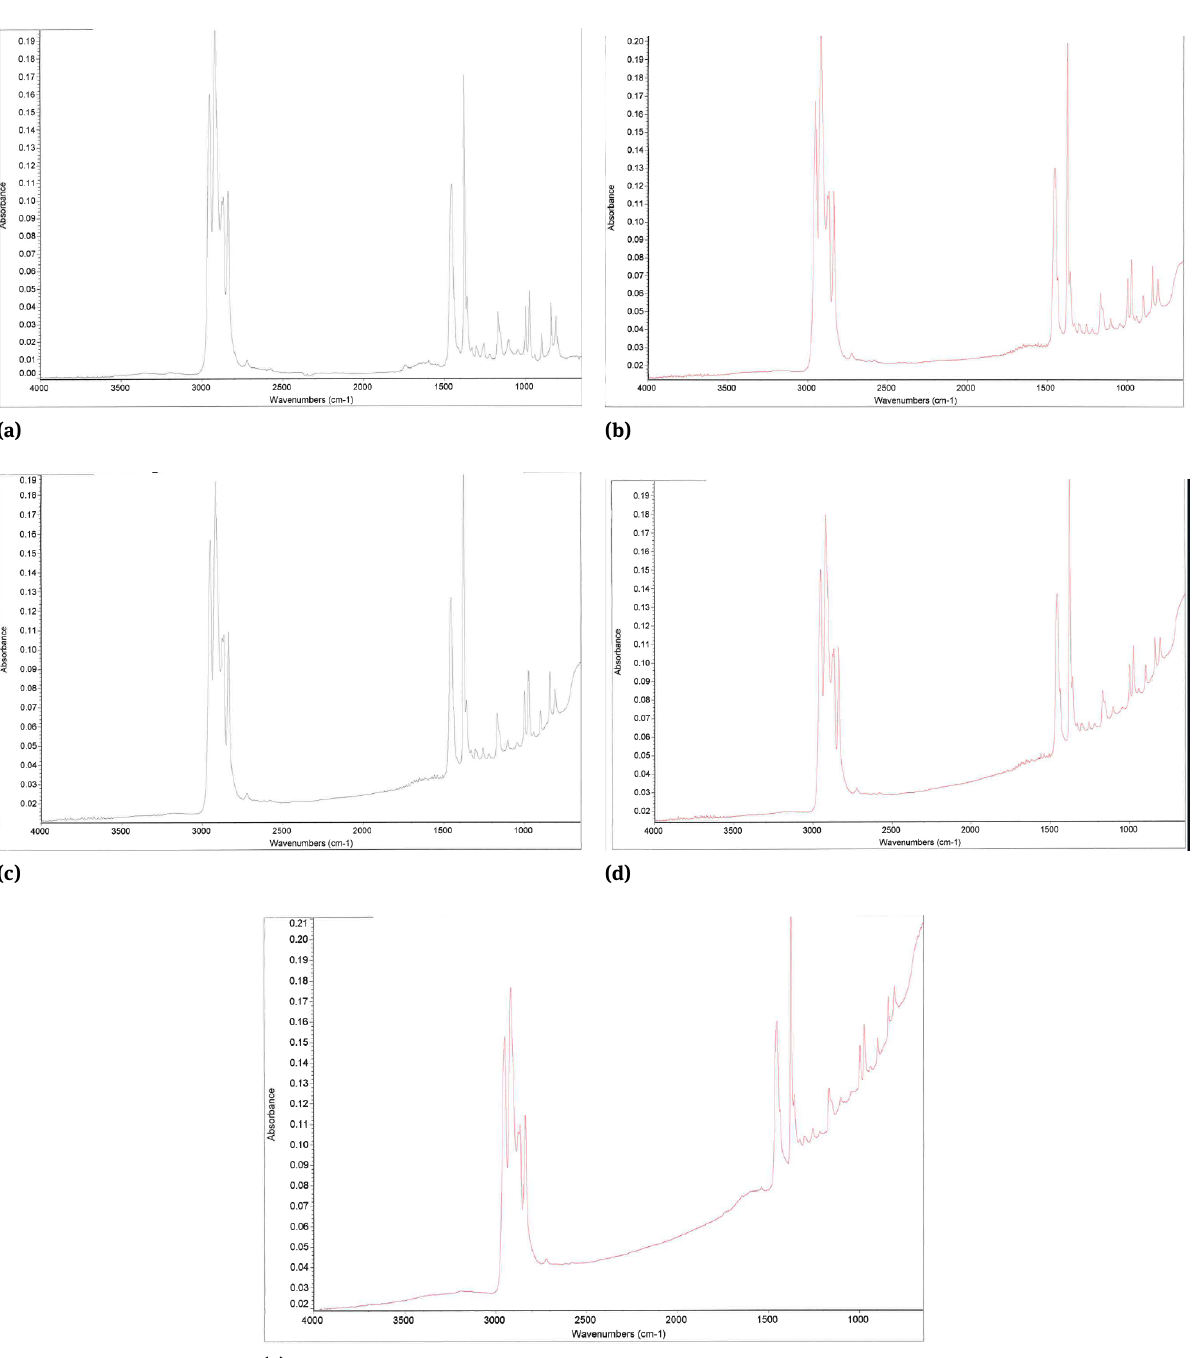
Figure 3: FTIR images of PP and its composites: (a) 100 wt.% PP, (b) PP/1xGnP/2n-MgO, (c) PP/2.5xGnP/2n-MgO, (d) PP/5xGnP/2n-MgO and (e)